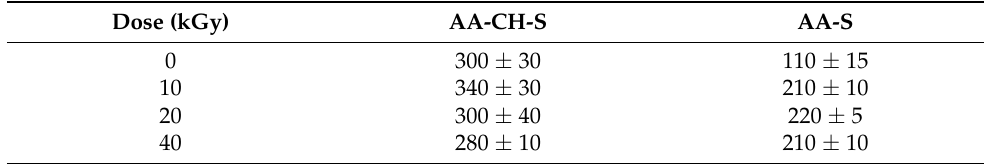
Table 4. WVTR (g · m − 2 · d − 1 ) results of AA-S and AA-CH-S films. Dose (kGy) AA-CH-S